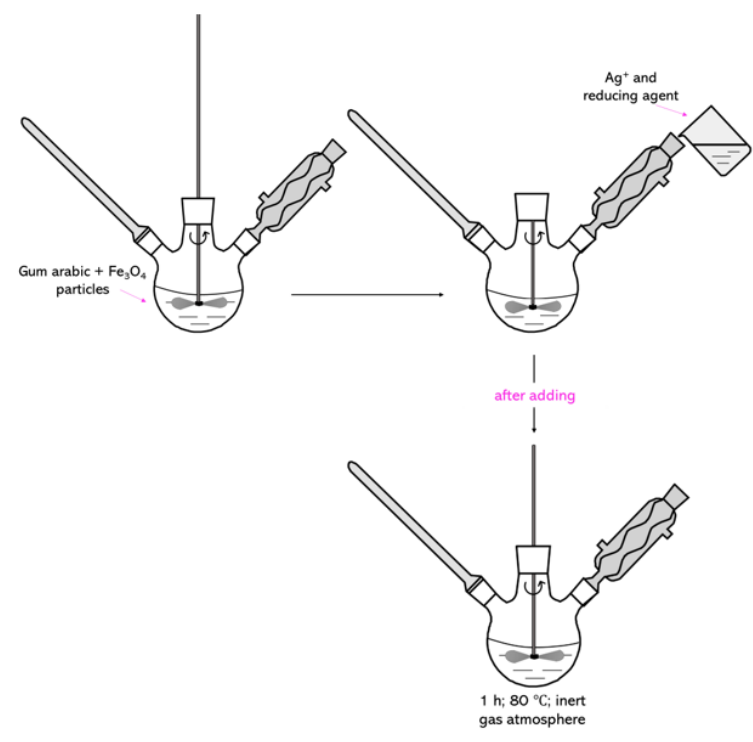
Figure 16. The scheme of Fe 3 O 4 @Ag